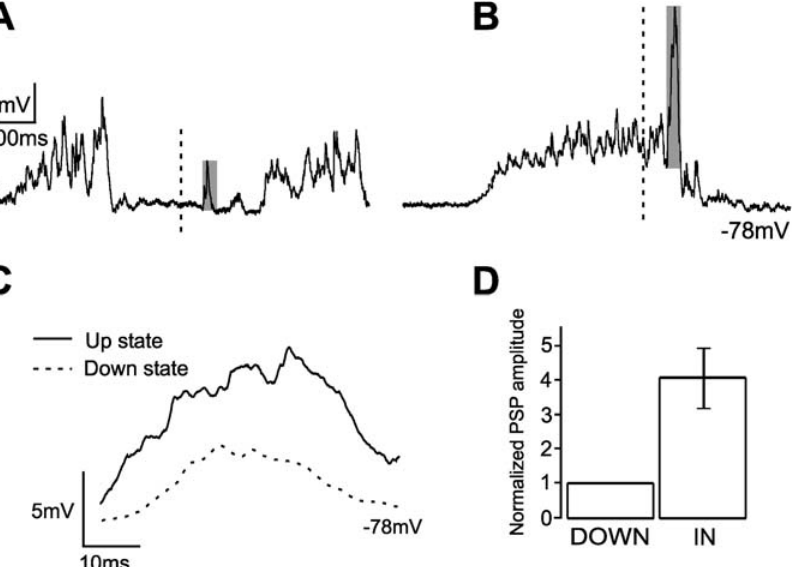
Figure 5. Visually evoked synaptic potentials in up versusdown states in the cortex invivo.A. Raw trace of a synaptic response (highlighted with a grey box) to a visual stimulus (discontinous line) during a down state. There are up states before and after the visual response. B. Raw trace of the synaptic response activated by the same visual stimulus but now during an up state. C. Average of the visual synaptic responses induced by the same stimulus during up (solid line) and down states (discontinous line). The averages are for 8 visual responses each, and they correspond to the recordings from a unique neuron. D. Relative amplitudes of the visually induced synaptic responses normalized for each neuron with respect to the ones during down states (n=9